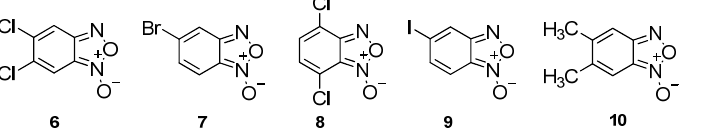
Figure 3. Representative benzofuroxans for which the phenomenon of crystal polymorphism was observed.